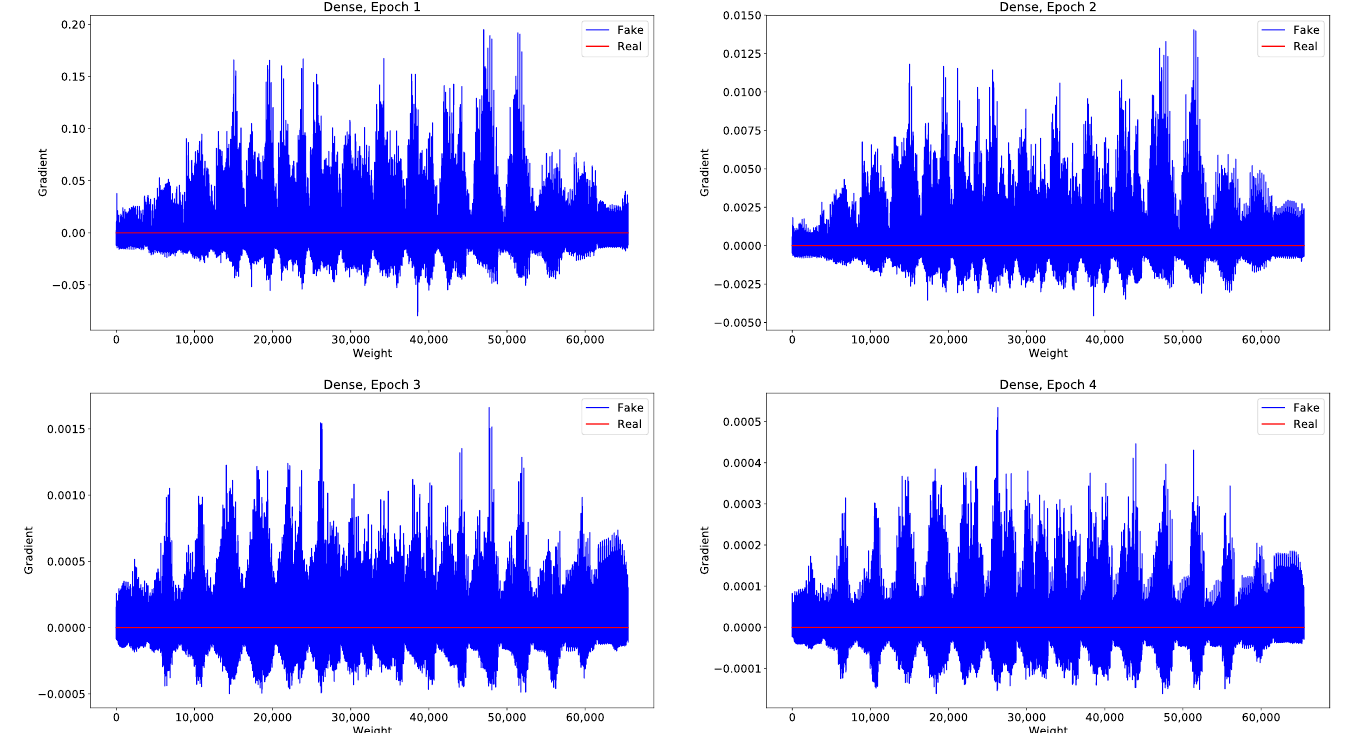
Figure 8. Gradients of the discriminators dense layer during fine-tuning.